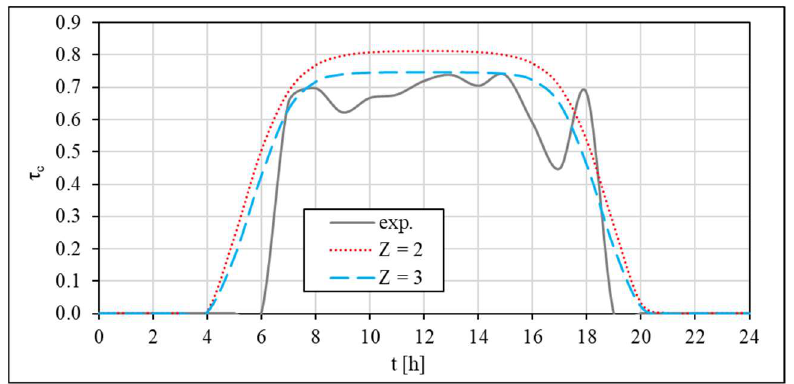
Figure 13. Comparison of theoretically calculated values with experimentally determined ones, for TST for polycarbonate sheet with twin wall rectangular structure on the 17th of July 2020.